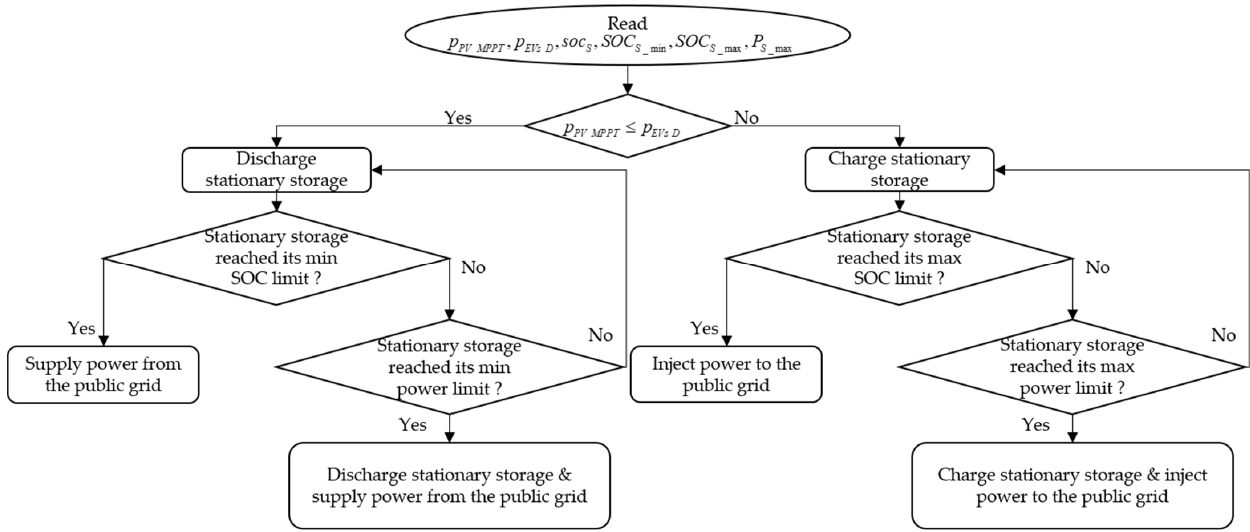
Figure 4. Flowchart for the power flow management of the PV-powered EV charging station.